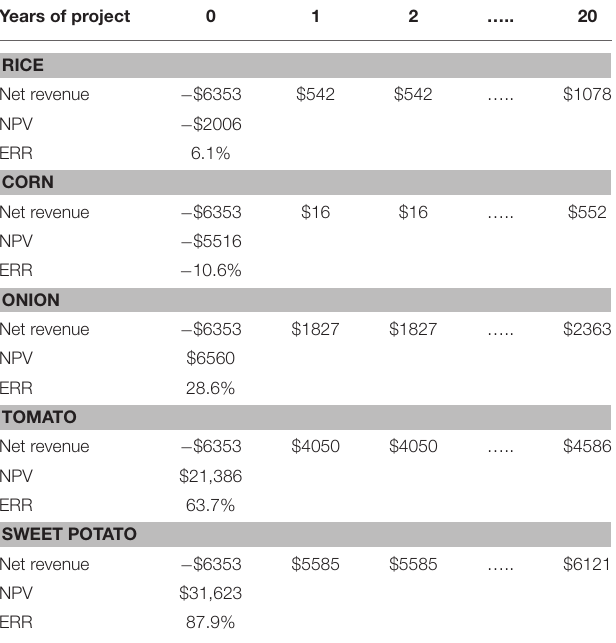
TABLE 3 | Scenario II—The economic NPV and ERR of crops per hectare in the irrigated parcels of S-SRV assuming the CI is equal to 42.2%, in US dollars.